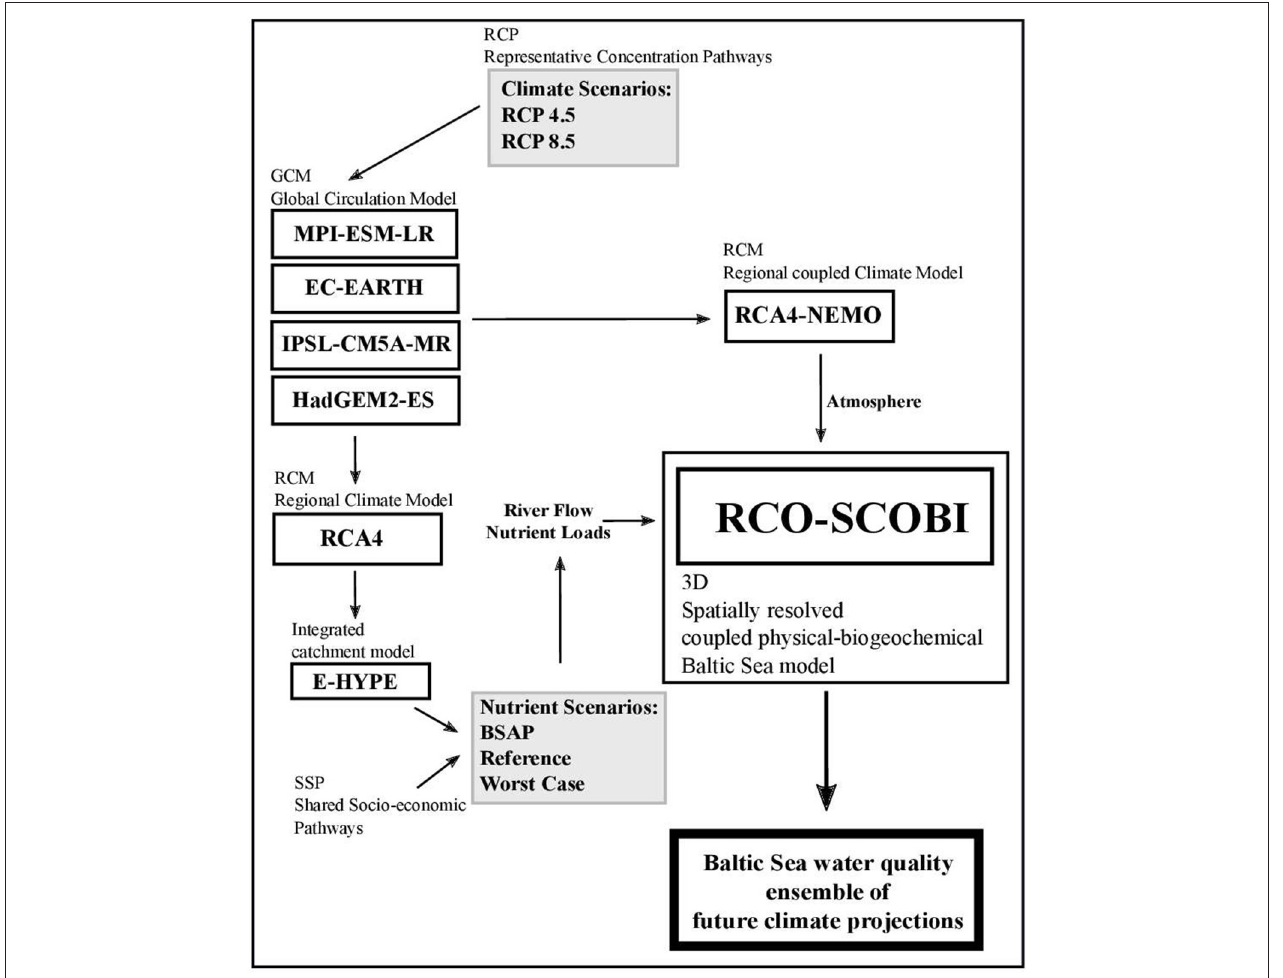
FIGURE 2 | Conceptual diagram of the modeling approach used in the